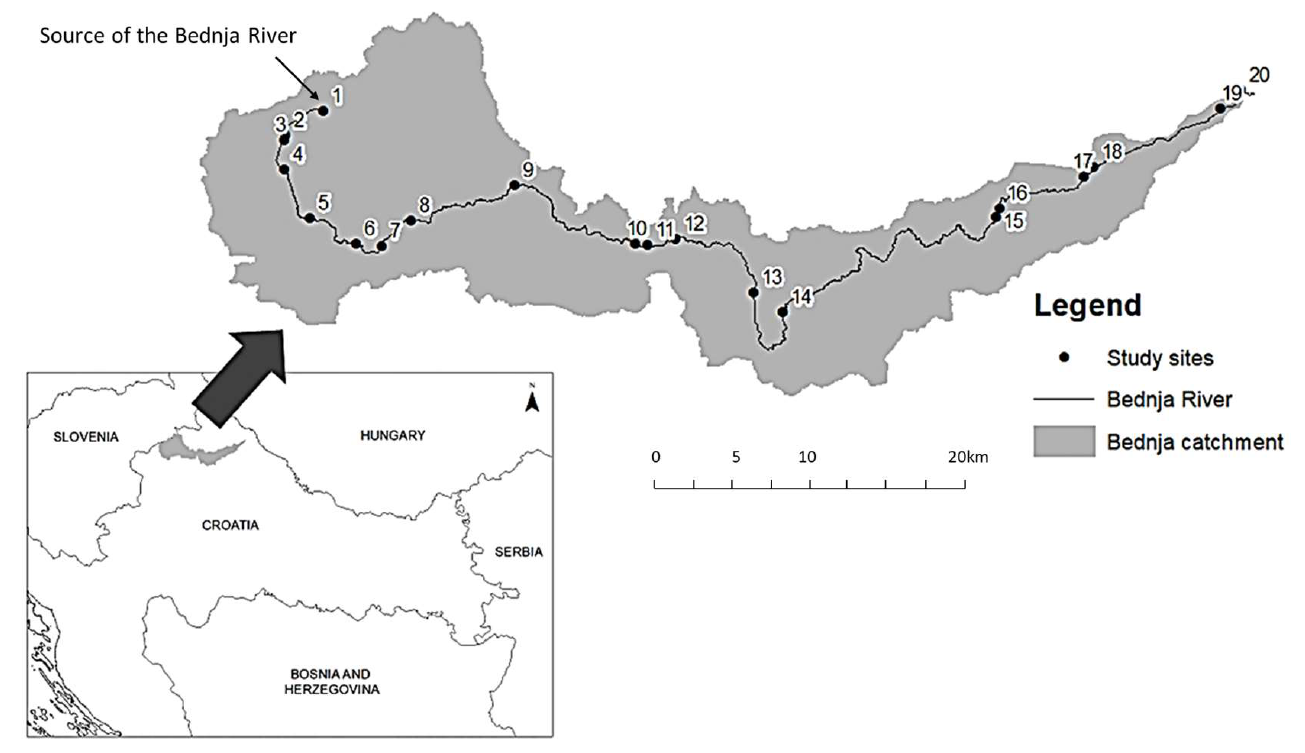
Figure 1. The location of the study area in northern Croatia—the Bednja River catchment and the distribution of sampling sites (1–20) along the river. (The details of each sampling site are presented in Table S1 in the Supplementary Material).